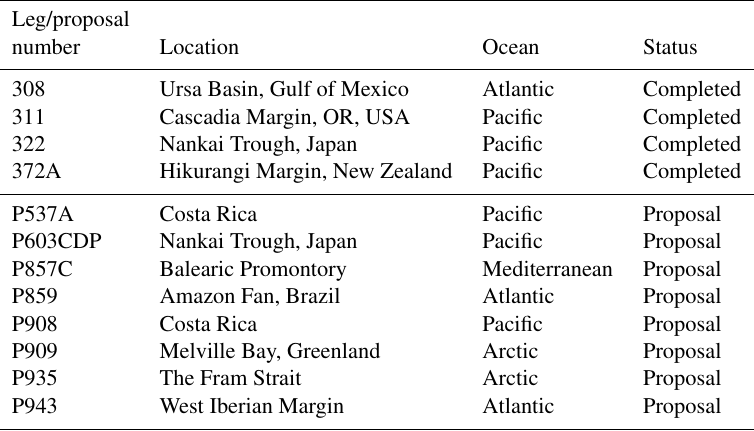
Table 1. IODP expeditions and proposals with 3D seismic